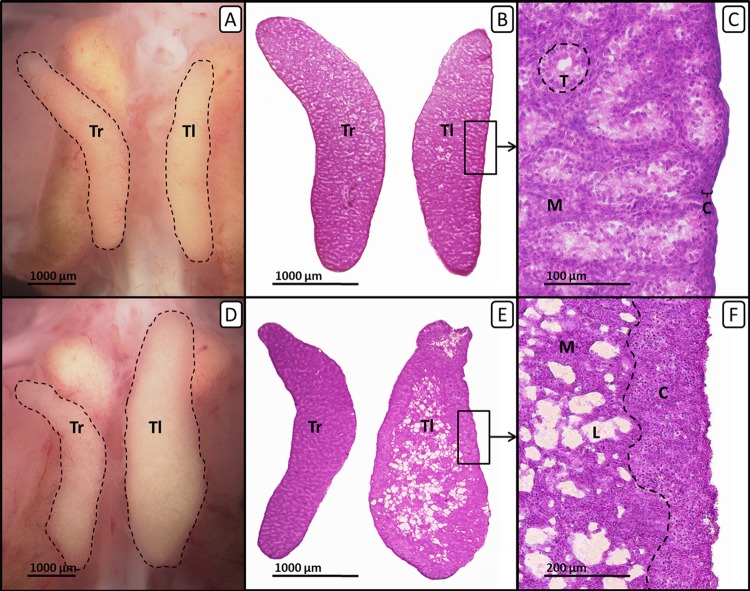
Right and left testis of genetic males of untreated control group and EE2-treated group on day 19 of embryonic development.Right and left testis of genetic males of untreated control group (A, B, C) and EE2-treated group (20 ng/g egg; D, E, F). (A, D) Unfixed right (“Tr”) and left (“Tl”) testis (outlined in black) on day 19 of embryonic development. Untreated control males (A) show testes of nearly identical size. EE2-treated males (D) show an unaffected right testis and a significantly enlarged left testis. (B, E) Histological thin sections (6 µm) of right (“Tr”) and left (“Tl”) testis. Untreated control males (B) show testes of nearly identical size and structure. EE2-treated males (E) show an unaffected right testis and a significantly enlarged left testis with female-like shape and structure. (C, F) Histological thin sections (6 µm) of left testis in close-up. Untreated control males (C) show a thin gonadal cortex layer (“C”) of three to four cells and interstitial space and seminiferous tubules (“T”) in the medulla (“M”). Left testes of EE2-treated males (F) show female-typical structures as a well-differentiated gonadal cortex region (“C”) with oocyte-like cells and a loosely arranged medulla (“M”) crossed by lacunar channels (“L”).